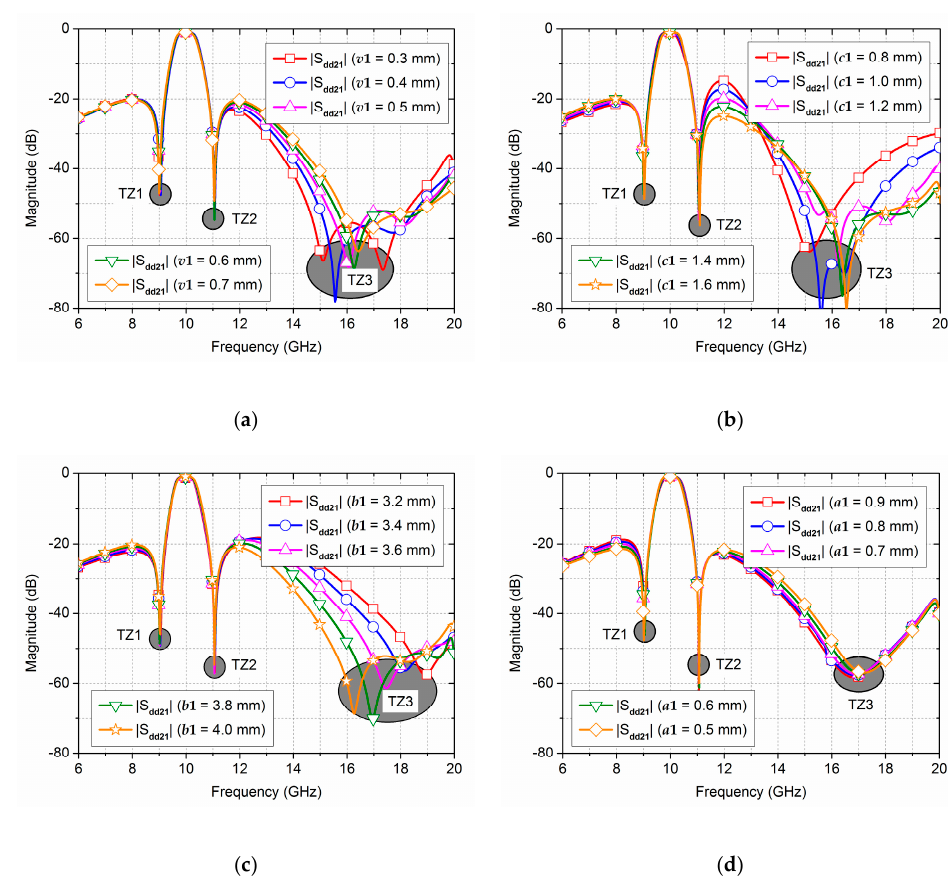
Figure 9. Simulated results of the proposed balanced filter with the variations of various geometrical parameters of the T-shaped spurlines: ( a ) v 1; ( b ) c 1; ( c ) b 1; ( d ) a 1.